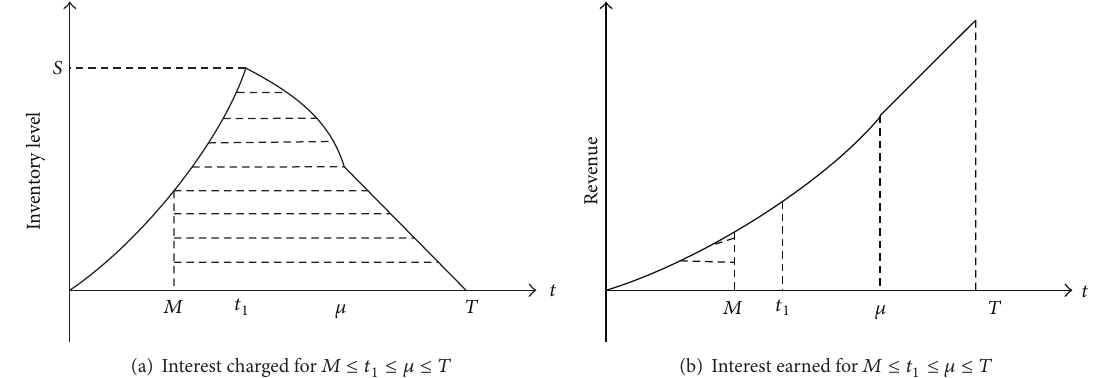
Figure 4: Interest charged and interest earned for 𝑀 ≤ 𝑡 1 ≤ 𝜇 ≤ 𝑇